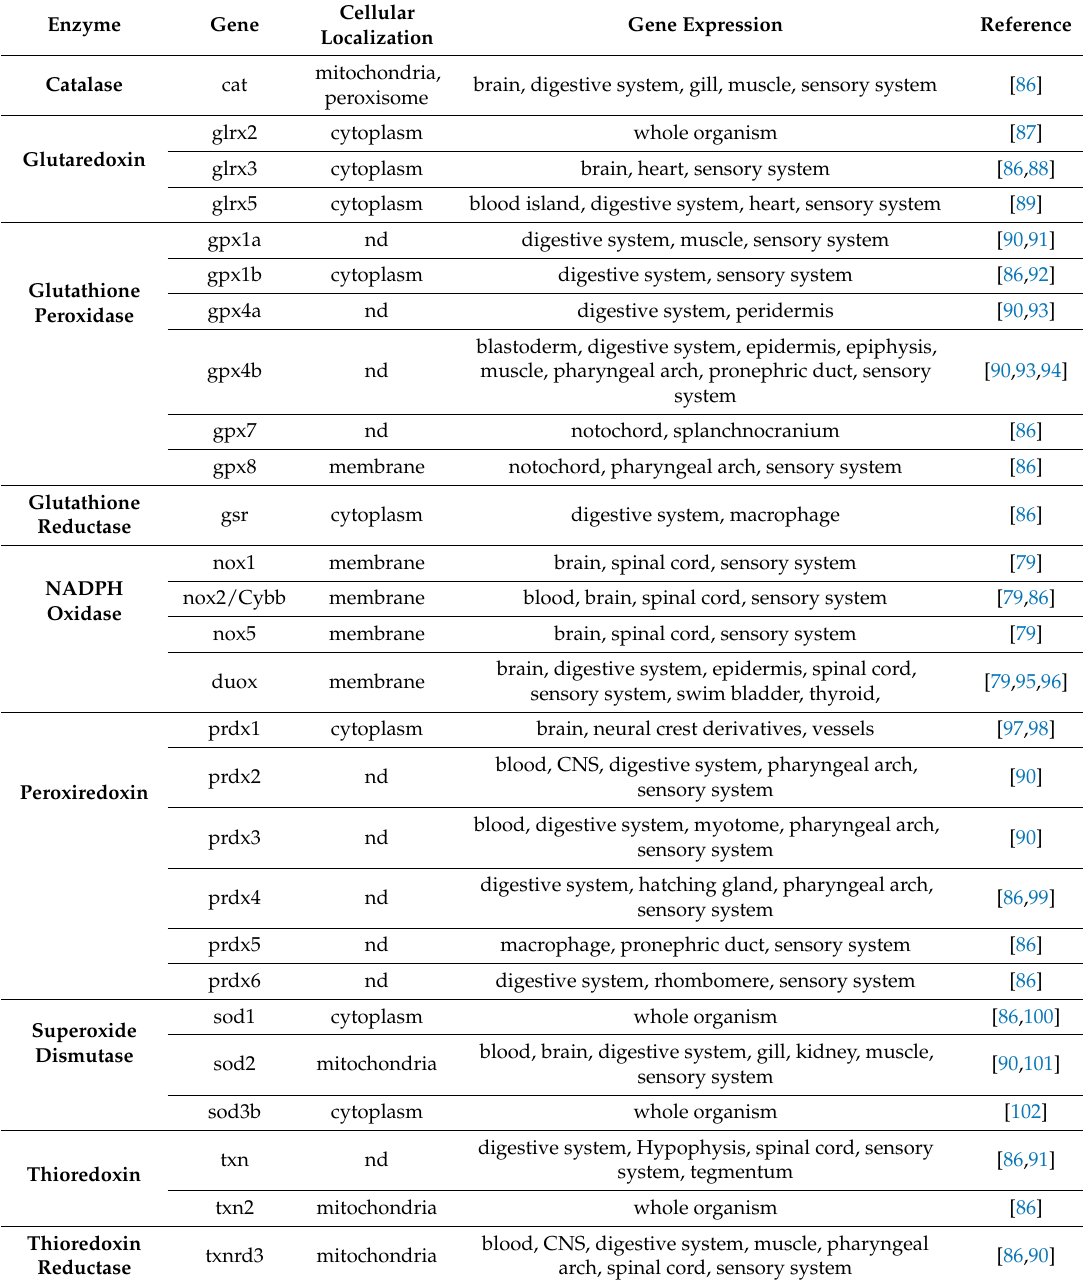
Table 1. Expression of the redox machinery genes during Danio rerio